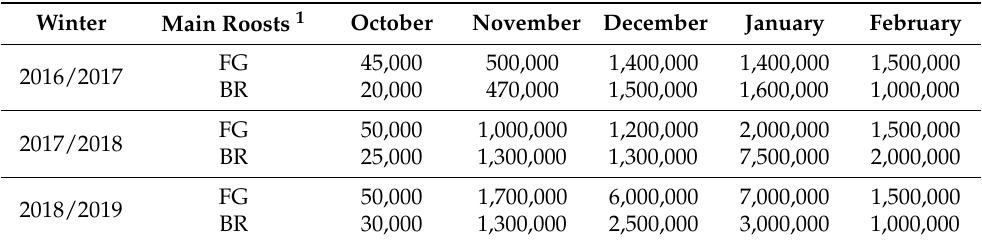
Table 1. Monthly estimate of the population size of wintering starling in Apulia and the main roosts in the three winters of the study.